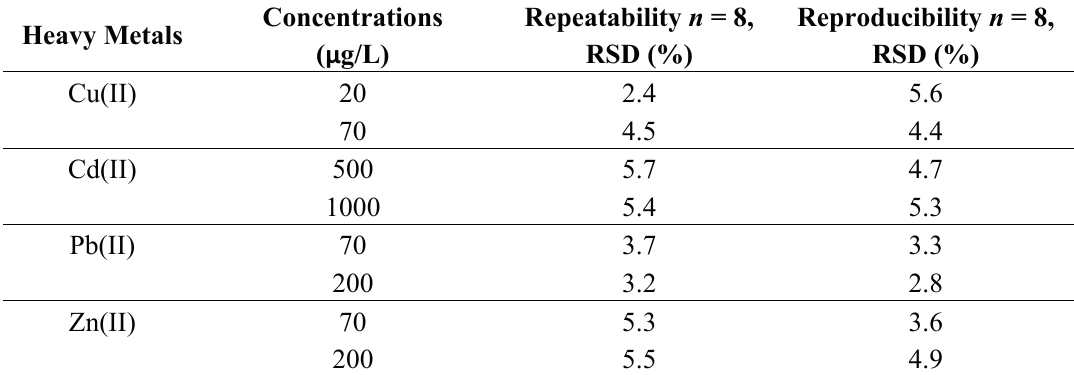
Table 1. Repeatability and reproducibility RSDs for A. fischeri -based toxicity microbiosensor towards Cu(II), Cd(II), Pb(II) and Zn(II) toxicities. Heavy